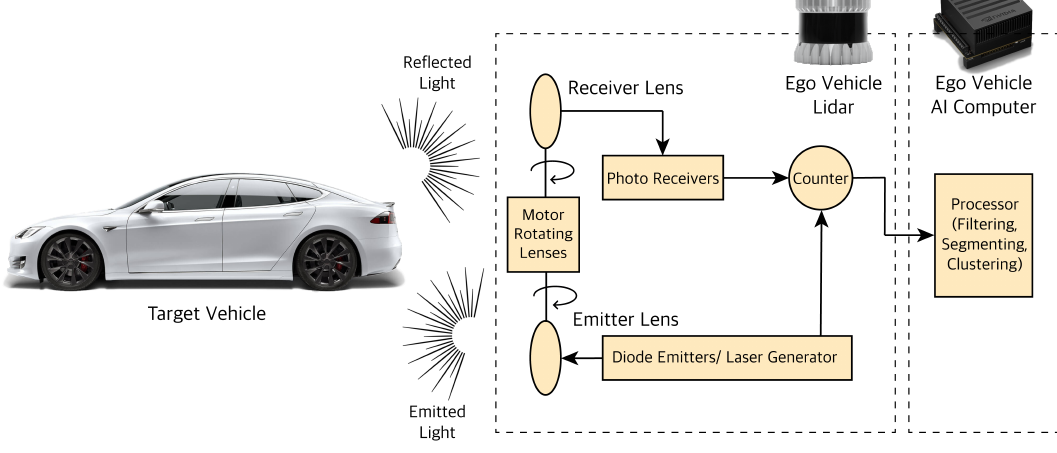
Figure 5. LiDAR sensor processing